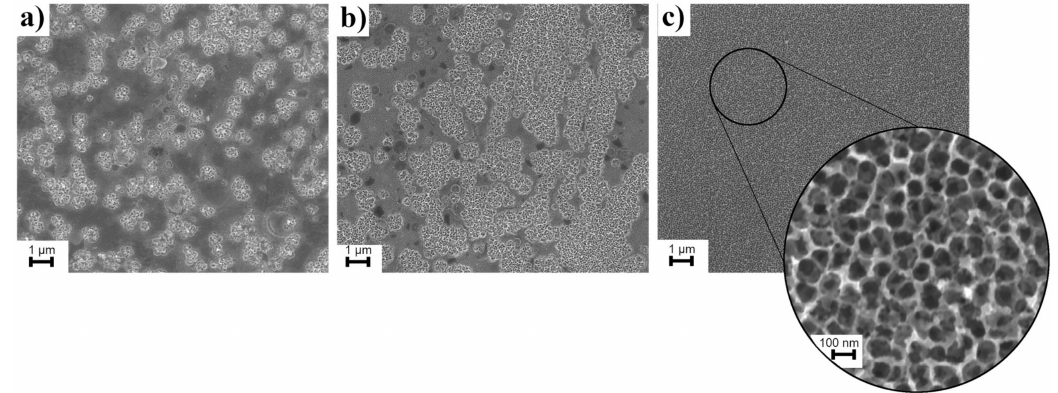
Figure 2. SEM micrographs showing the process of the WO 3 nanopores formation into W foil during anodization in 1 M H 2 SO 4 solution of 0.1 M NaF at various times at a constant potential equal to 40 V.